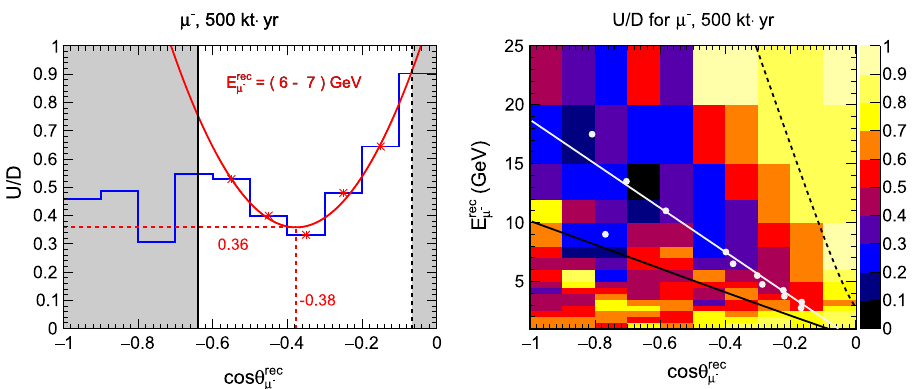
Fig. 9 Demonstration of the algorithm for identifying the valley and determining its alignment. Left panel: the blue line represents the U/D ratio as a function of (cos θ rec μ ) for a fixed energy bin. The gray areas are those with log 10 [ L rec μ / E rec μ ] < 2 . 2 and > 3 . 1. The red curve represents the parabolic fit to the U/D ratios with 2 . 2 < log 10 [ L rec μ / E rec μ ] < 3 . 1. Right panel: the colored background shows the U/D ratios for each bin in the ( E rec μ , cos θ rec μ ) plane, for a particular 500 kt · yr data set.